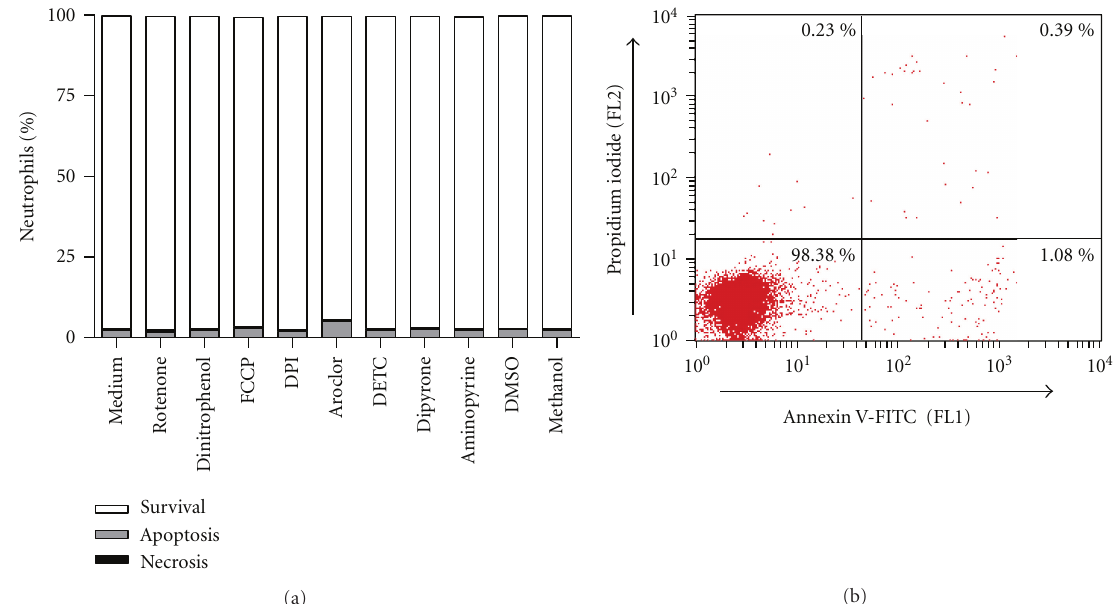
Figure 2: Inhibitors of various steps of ROS production are not toxic and do not induce apoptosis in human neutrophils. Freshly isolated human neutrophils were incubated with or without inhibitors (10 µ M Rotenone, 10 µ M Dinitrophenol, 500 nM FCCP, 20 µ M DPI, 38 µ M Aroclor, 10 µ M DETC, 200 µ M Dipyrone, and 200 µ M Aminopyrine) for 4h at 37 ◦ C. DMSO and methanol were used as solvent controls for Rotenone and Aroclor. Apoptosis and cell death were assessed by flow cytometry using stainings with Annexin V-FITC and propidium iodide, respectively. (a) The e ff ect of various inhibitors on apoptosis and necrosis of neutrophils in vitro . Data are shown as mean from 3 independent experiments. (b) Representative dot plot of a flow cytometry analysis of human neutrophils cultured without inhibitor. The x - axis shows the Annexin V-FITC fluorescence, at the y -axis the propidium iodide fluorescence is indicated. Events in the lower right quadrante (1.08%) represent the apoptotic cells whereas events in the upper quadrants represent the necrotic